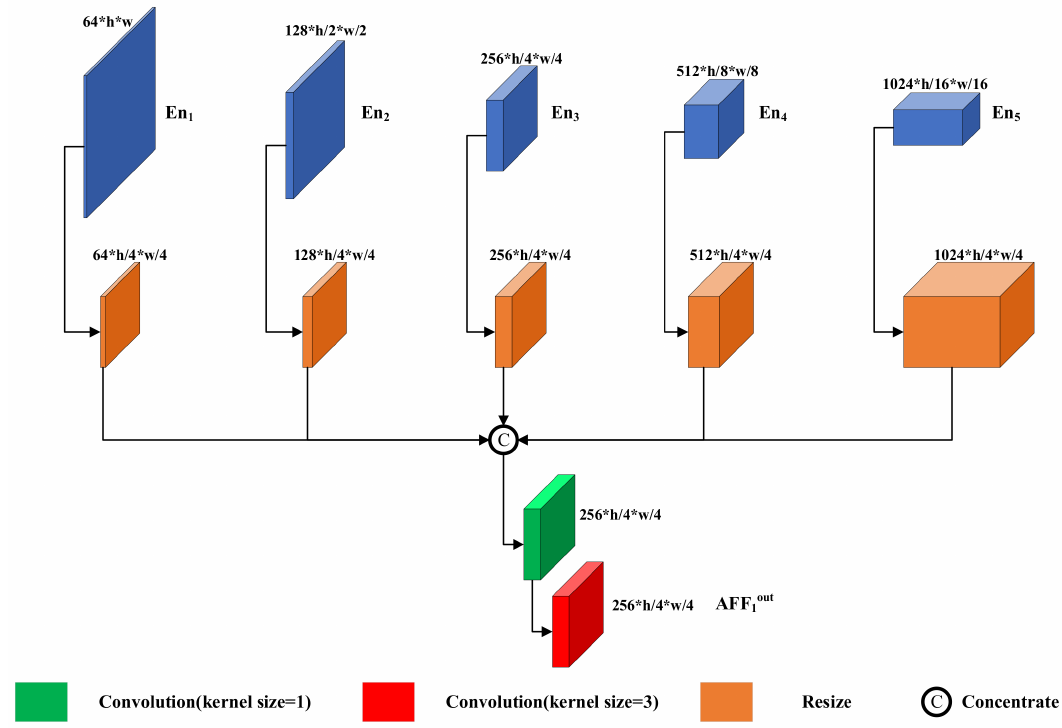
Figure 5. Asymmetric feature fusion module structure. The AFF module consists of resized modules, a 1 × 1 convolution kernel, and a 3 × 3 convolution